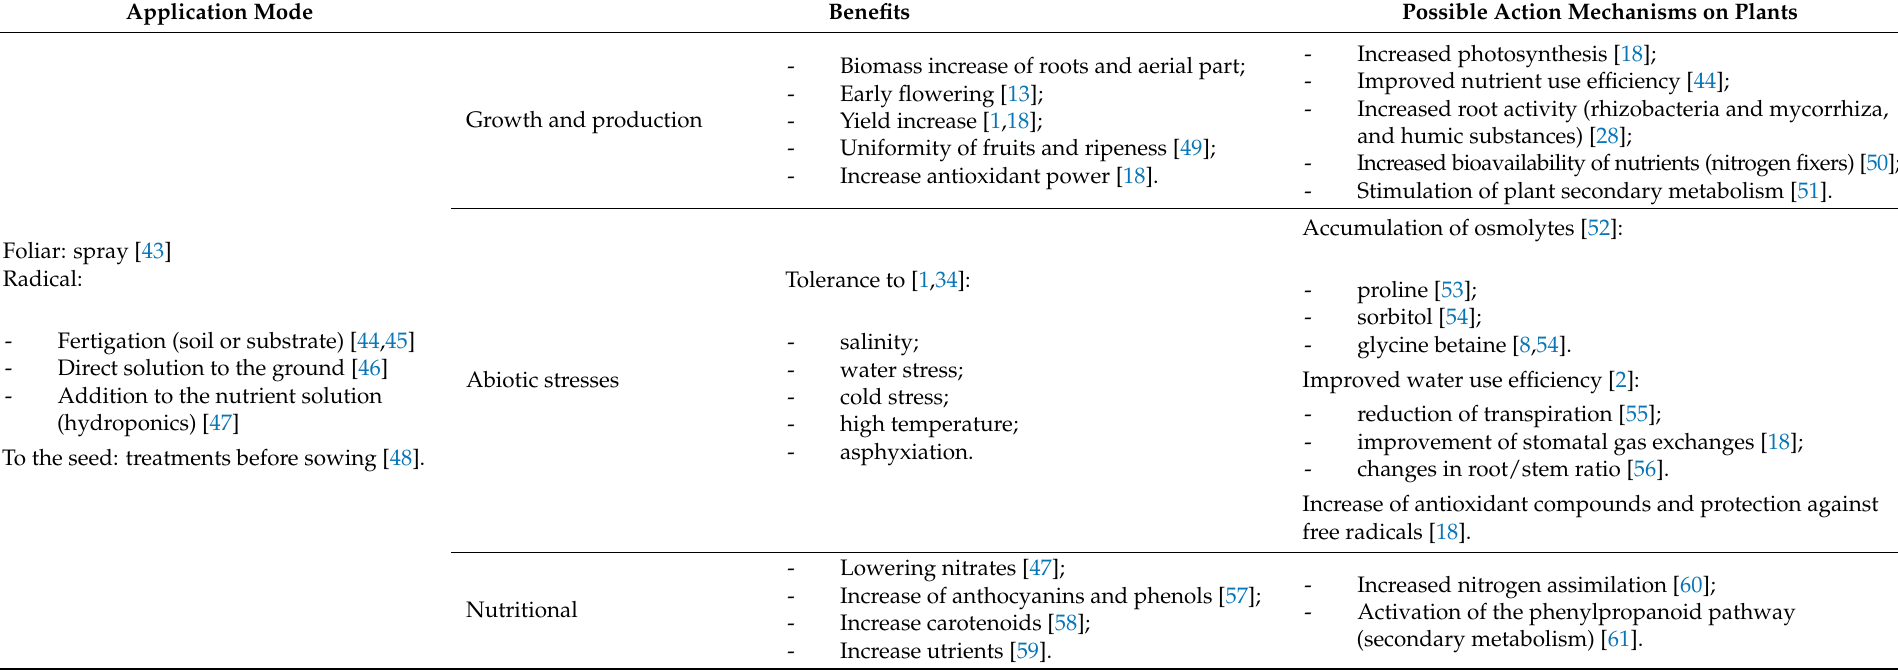
Table 1. Effects on the plant and possible mechanism of action of